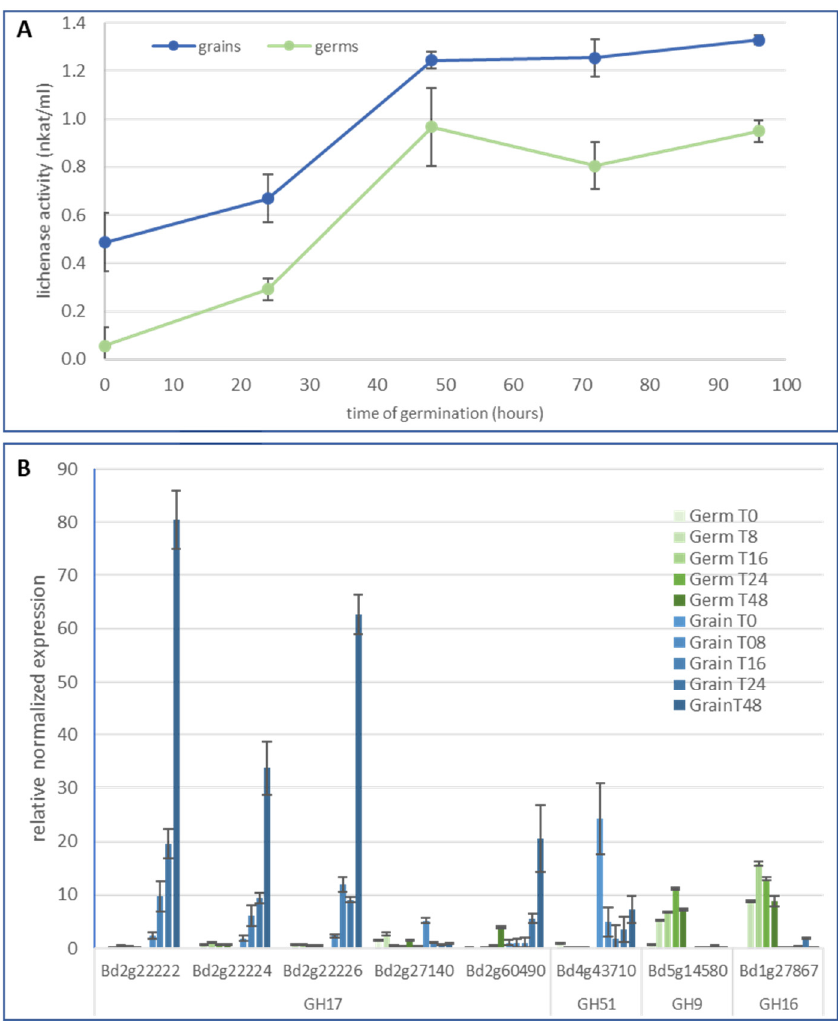
Figure 4. ( A ). Lichenase activity measured from protein extracts of germinated grains (without germ) and germs. Lichenase activity was determined by the Nelson method and barley MLG was used as substrate. ( B ). Transcript levels (qRT-PCR) of Brachypodium genes encoding putative lichenases during the germination (0, 8, 16, 24, and 48 h of germination) in grains and germs. Error bars represent standard deviation of the mean ( n = 3).